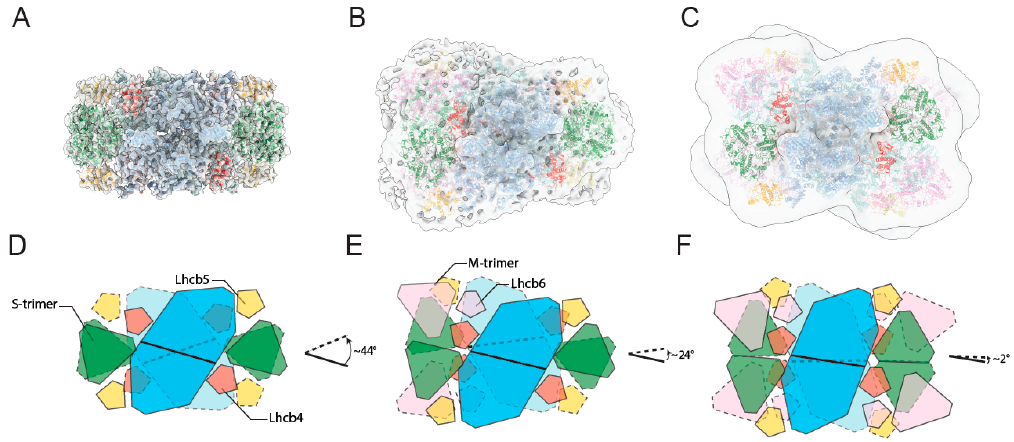
Figure 4. Cryo-EM density maps of paired PSII-LHCII supercomplexes with different antenna size isolated from plants grown in high-light and low-light. Top view towards the lumenal surface of the 3D maps of the supercomplexes (C 2 S 2 ) 2 -H at 6.5 Å ( A ), (C 2 S 2 M) 2 -H at 11 Å ( B ), (C 2 S 2 M 2 ) 2 -L at 13.1 Å ( C ), fitted with high-resolution structures (PDB: 5XNL devoid of one LHCII-M trimer and one Lhcb6 in panel ( B ); PDB: 5XNL in panel ( C )) [22], and corresponding schematic representations ( D – F ) showing the positions of all fitted supercomplex components and rotational offsets measured between the plane perpendicular to the axis of symmetry of the PSII dimeric core of the lower supercomplex with respect to its counterpart of the upper supercomplex. Subunits coloured as follows: PSII dimer in cyan, LHCII-S trimer in green, Lhcb4 in red, Lhcb5 in orange, LHCII M-trimer and Lhcb6 in pink (dark colours for upper supercomplex, light colours for lower supercomplex). In the scheme, colours match the structures of panels ( A – C ); solid lines for upper supercomplex, dashed lines for lower supercomplex.